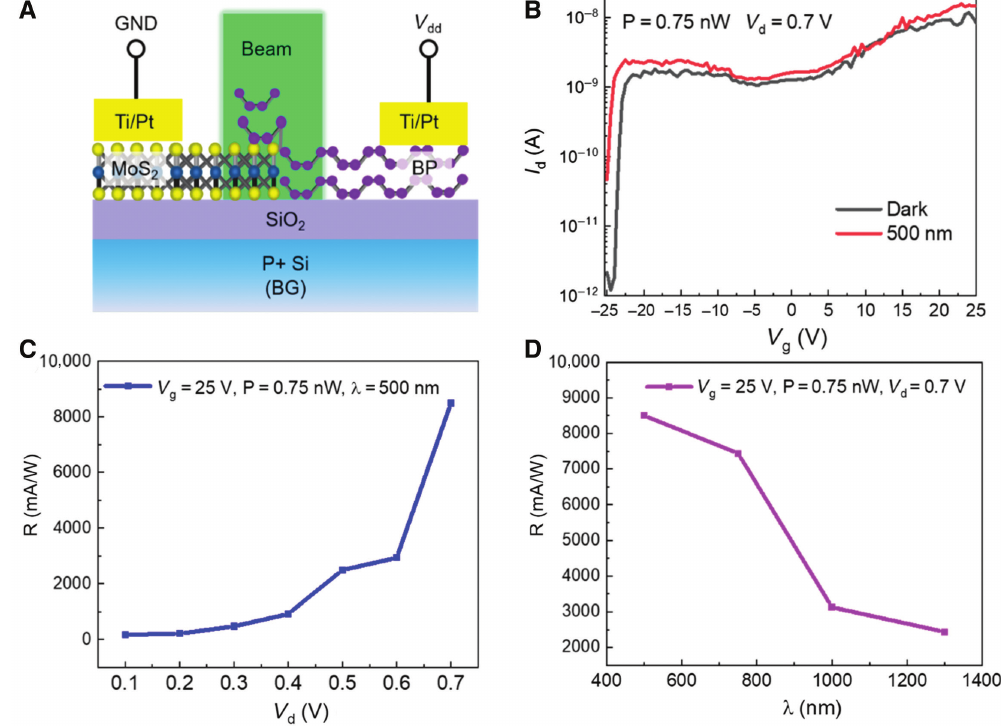
heterojunction. 2 - V transfer curves in log scale obtained in the dark d g , which ranges from 100 to 700 mV. (D) R vs. d